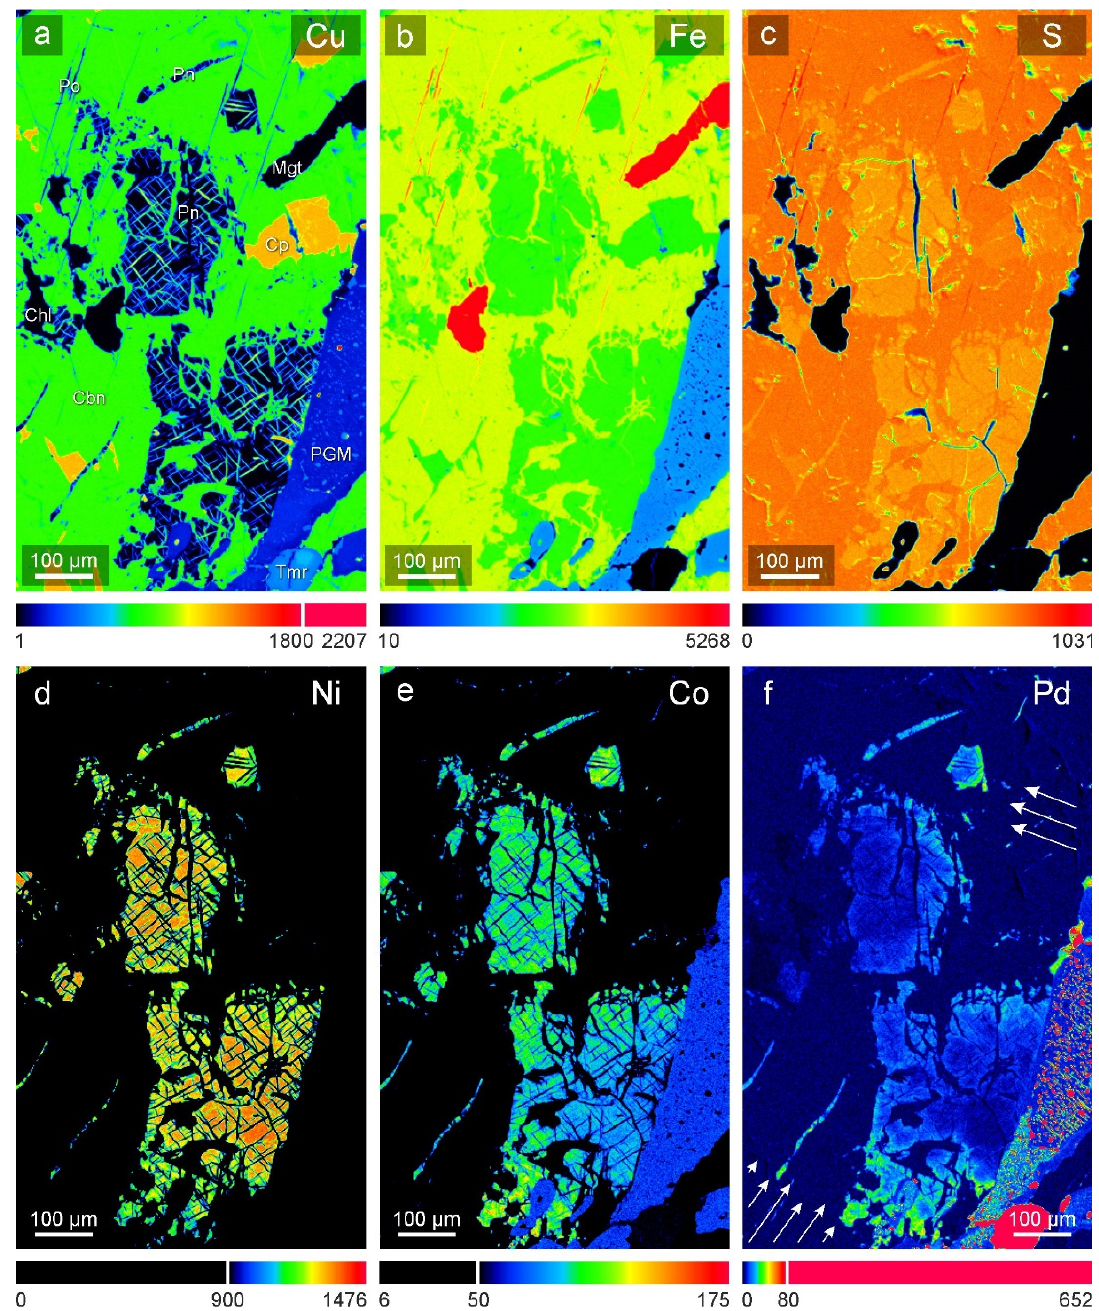
Figure 8. EDS elemental distribution maps in cubanite ore (sample 32 − 11, depth 76.5 m). ( a ) Cu; ( b ) Fe; ( c ) S; ( d ) Ni; ( e ) Co; ( f ) Pd. Arrows show the probable direction of palladium enrichment in pentlandite (see explanations in the Chapter 5.3). For an explanation on the color scales, see Section 3.2. Abbreviations: Cbn—cubanite; Chl—chlorite, Cp—chalcopyrite; Mgt—magnetite; Pn—pentlandite; Po—pyrrhotite; PGM—multiphase PGM grain; Tmr—taimyrite.